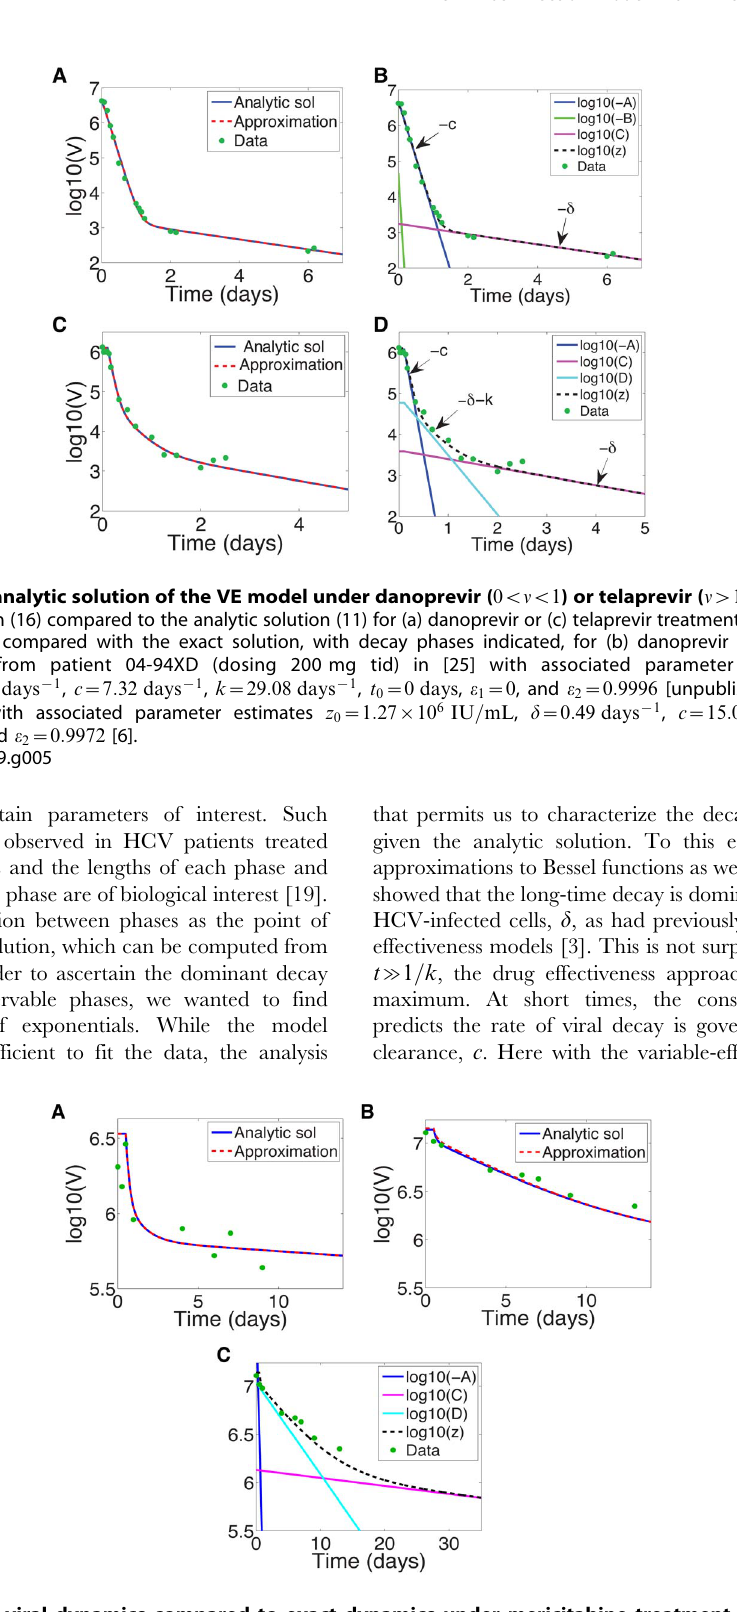
Figure 6. Approximation to viral dynamics compared to exact dynamics under mericitabine treatment, 750 mg qd, n w 1 . (a) For patient 92102 from [16], characterized as ‘‘flat’’. (b) For patient 92103 from [16], characterized as ‘‘non-flat’’. (c) Different exponential terms in approximate solution (16) compared with the exact solution for patient 92103, characterized as ‘‘non-flat’’. Parameter estimates from [16]: For patient 92102, z 0 ~ 10 7 : 14 IU = mL , d ~ 0 : 021 days { 1 , c ~ 6 days { 1 , k ~ 0 : 20 days { 1 , t 0 ~ 0 : 5 days , e 1 ~ 0 : 27 , and e 2 ~ 0 : 91 ; for patient